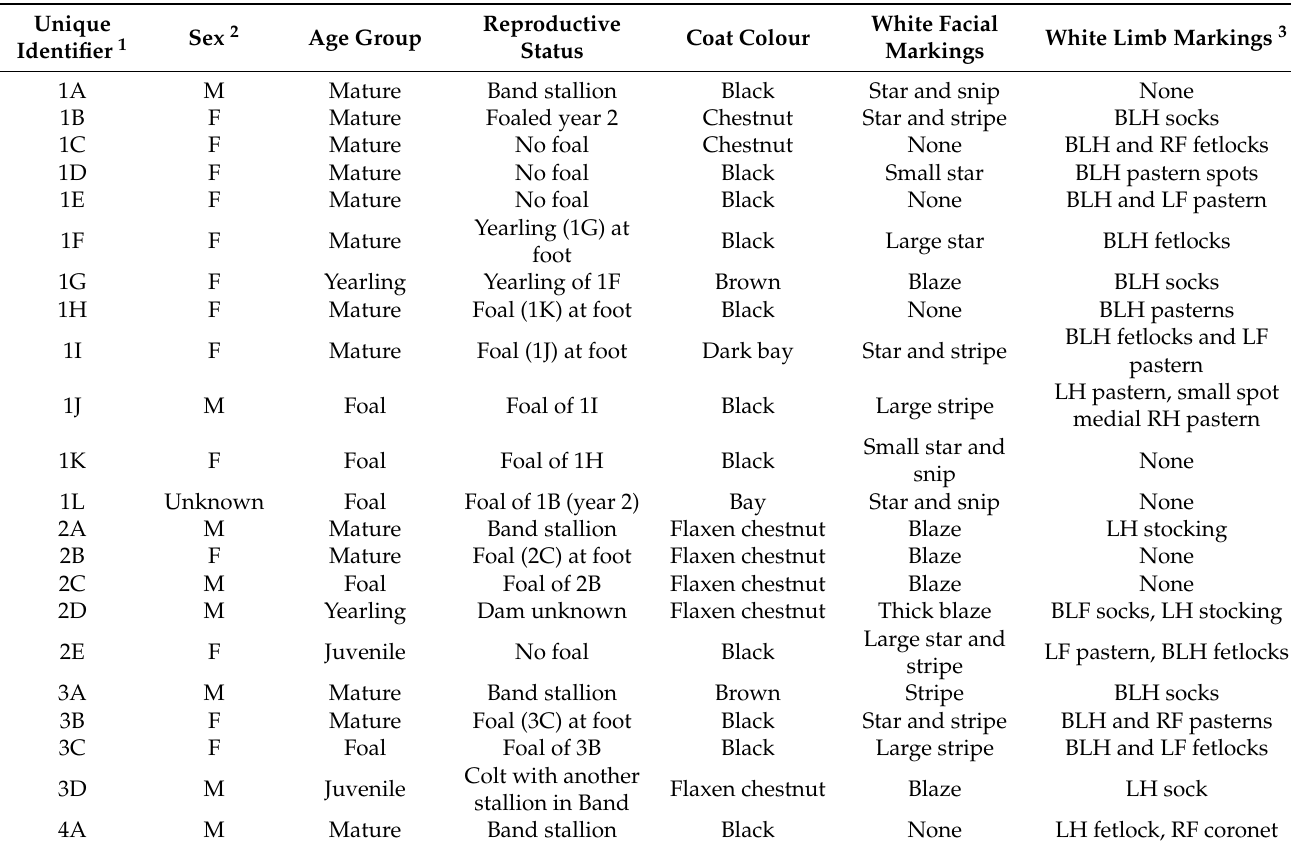
Table 5. Details of the population and unique identifying